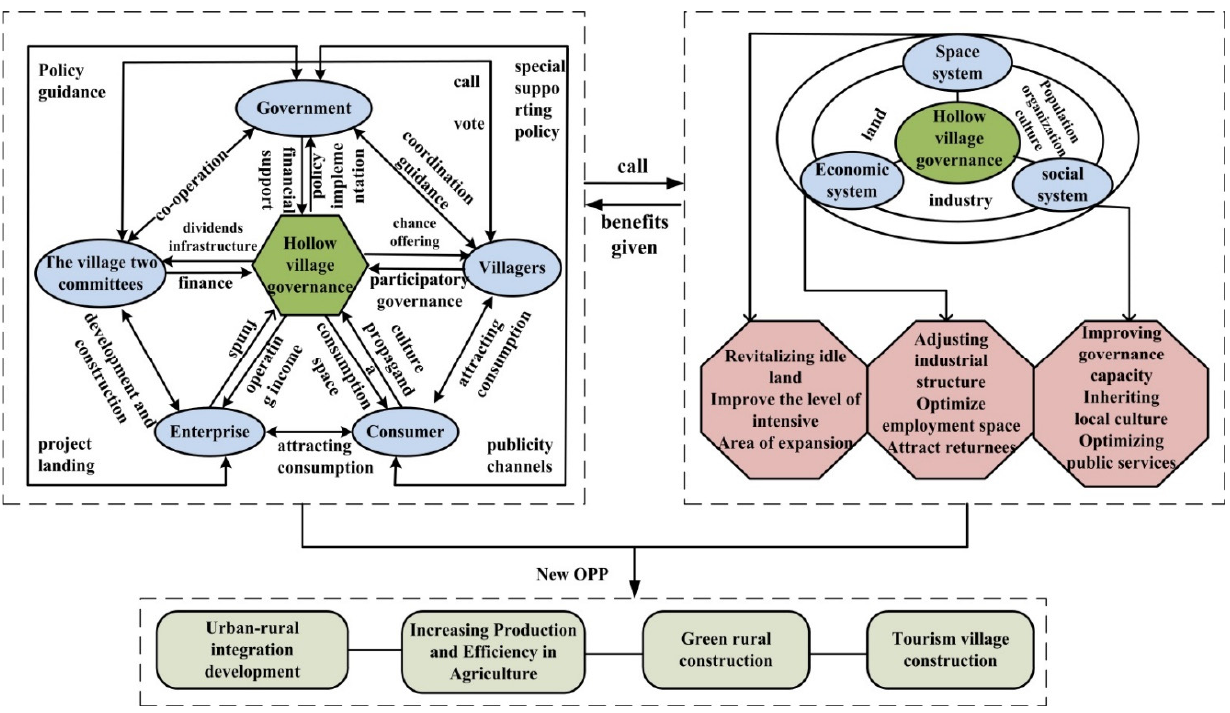
Figure 3. Hollow village governance process based on actor–network theory.